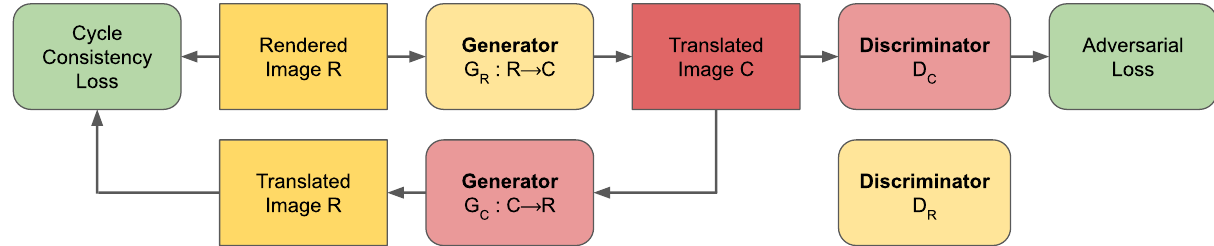
Figure 2. Overview of the utilized GAN system. The training pass for the direction from a rendered image to a captured image R → C is shown. Besides the Adversarial Loss, a Cycle Loss is utilized to encourage inverse mappings such that G R ( G C ( c )) ≈ c . The training pass for the opposite direction C → R is executed likewise. Discriminator D R is illustrated for